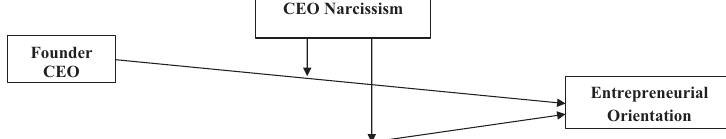
Figure 1. Research